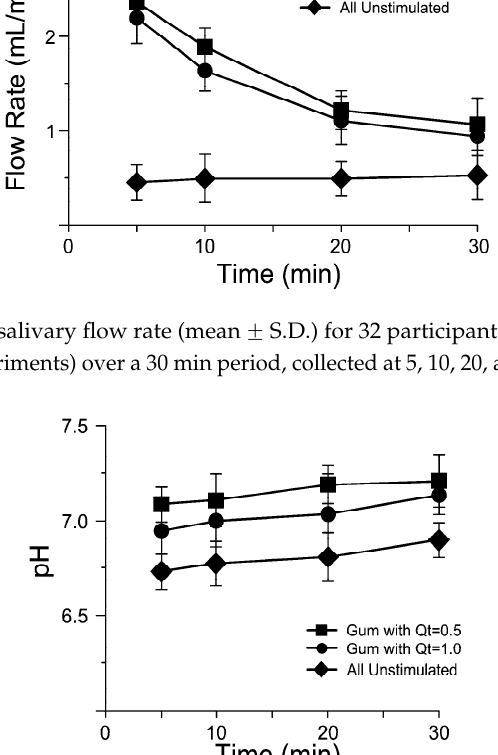
Figure 1. The changes in salivary flow rate (mean ± S.D.) for 32 participants (three samples for each